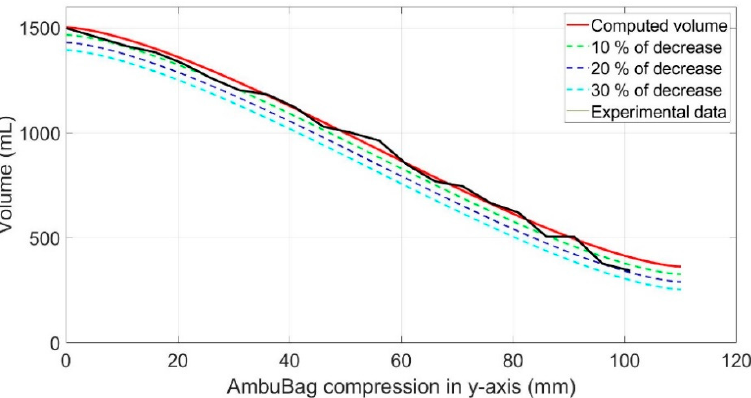
Figure 18. Residual volume in AmbuBag with changing extension of the pneumatic actuator.